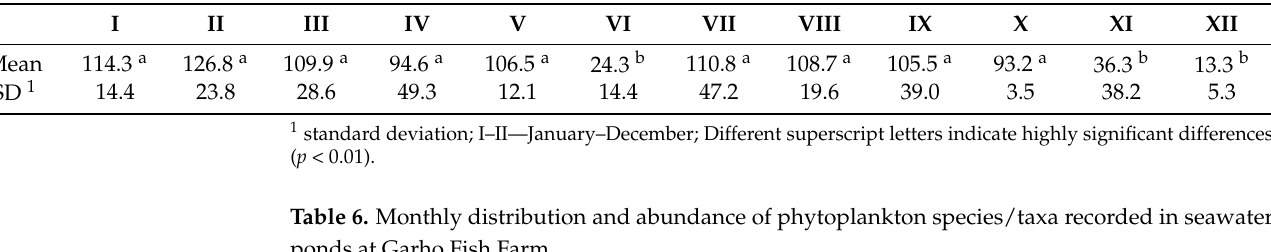
Table 5. Monthly variation of TSS (mg/L) recorded in seawater ponds at Garho Fish Farm.